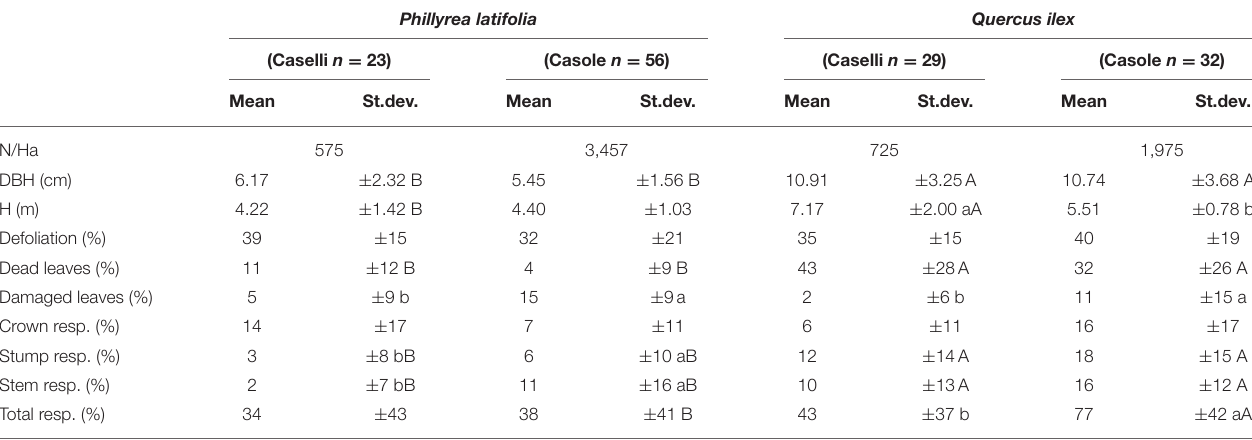
TABLE 1 | Drought-induced damage and recovery parameters of the most abundant plant species Phillyrea latifolia and Quercus ilex in 2018 in the permanent plots at Caselli and Casole d’Elsa ( n = number of the assessed trees at each site). Phillyrea latifolia Quercus ilex (Caselli n = 23) (Casole n = 56) St.dev. St.dev. St.dev.